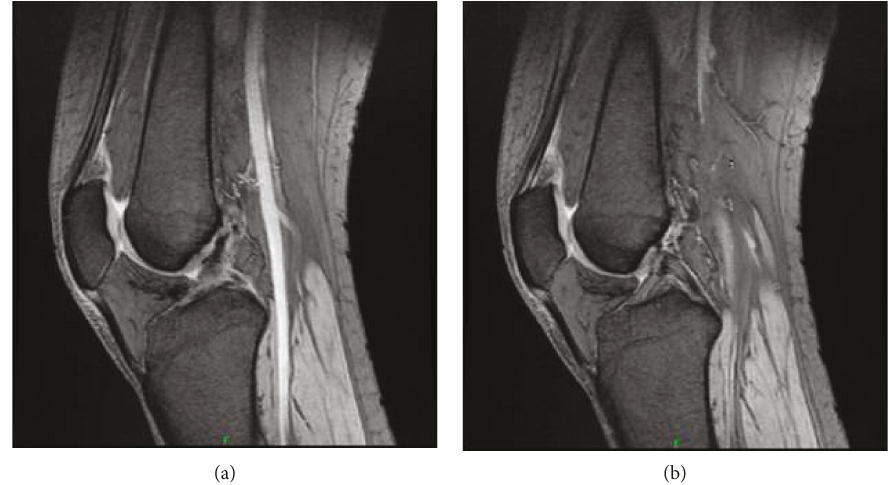
Figure 2: (a) Lateral-view T2 sequence MRI of the left knee 6-month post arthroscopic resection of posterior-compartment PVNS, showing no more compressive e ff ect on both the cruciate ligaments and the popliteal vessels. (b) There is a signi fi cant decrease in the soft tissue enhancement suggestive of decreased in fl ammation in the region of the resected lesion. There is no evidence of interval appearance of new susceptibility artifacts or blooming e ff ect suggesting